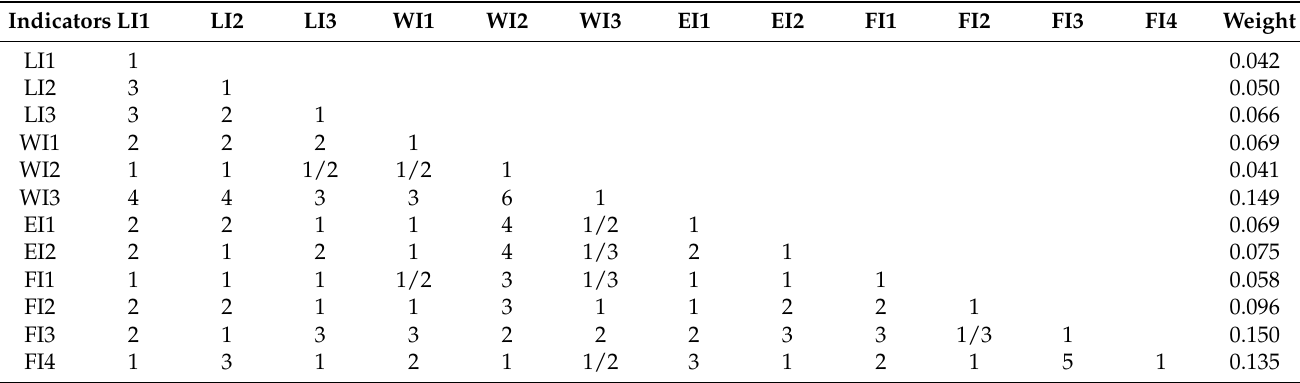
Table 2. PCM and weight for the LWEF nexus